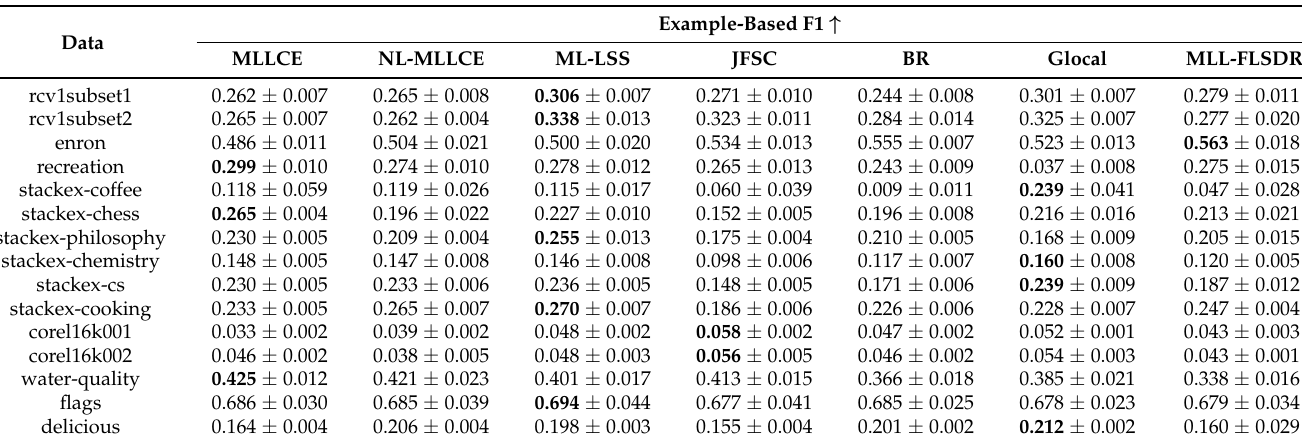
Table 8. The experimental results (mean ± standard) of all comparison methods in this paper in terms of Example-based F1. ↑ means that the larger the value, the better the performance is. The best results in each row are highlighted in bold